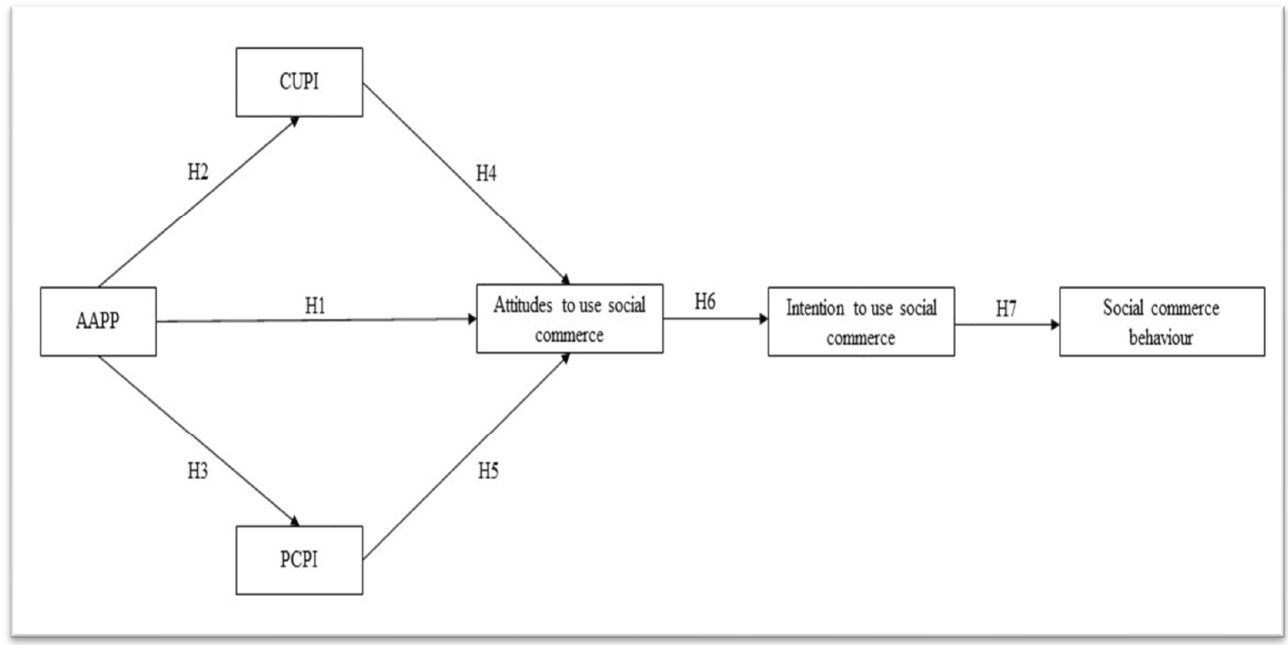
Figure 1. Research model. Note: H1-7 mean hypothesis.